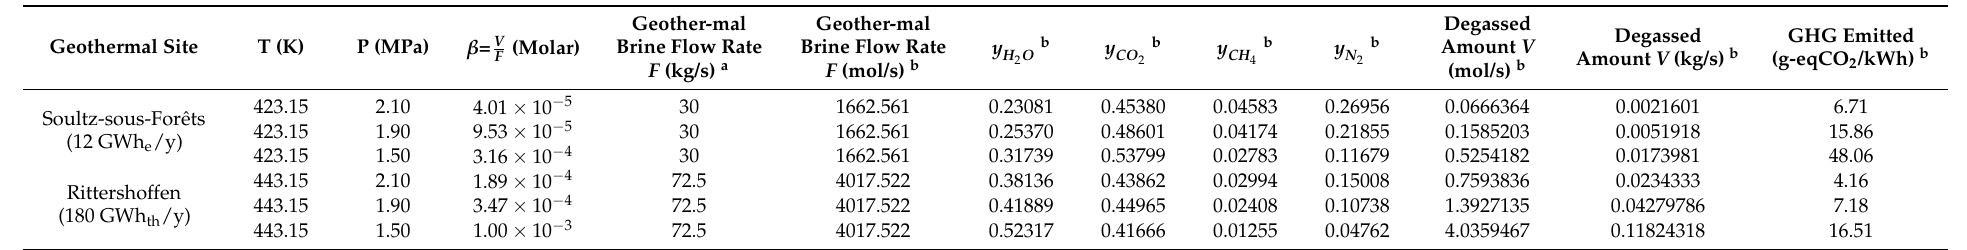
Table 6. Prediction of GHG emission rates in the Upper Rhine Graben geothermal sites at different pressures and temperatures: estimated amounts and compositions of emitted gases. Geothermal